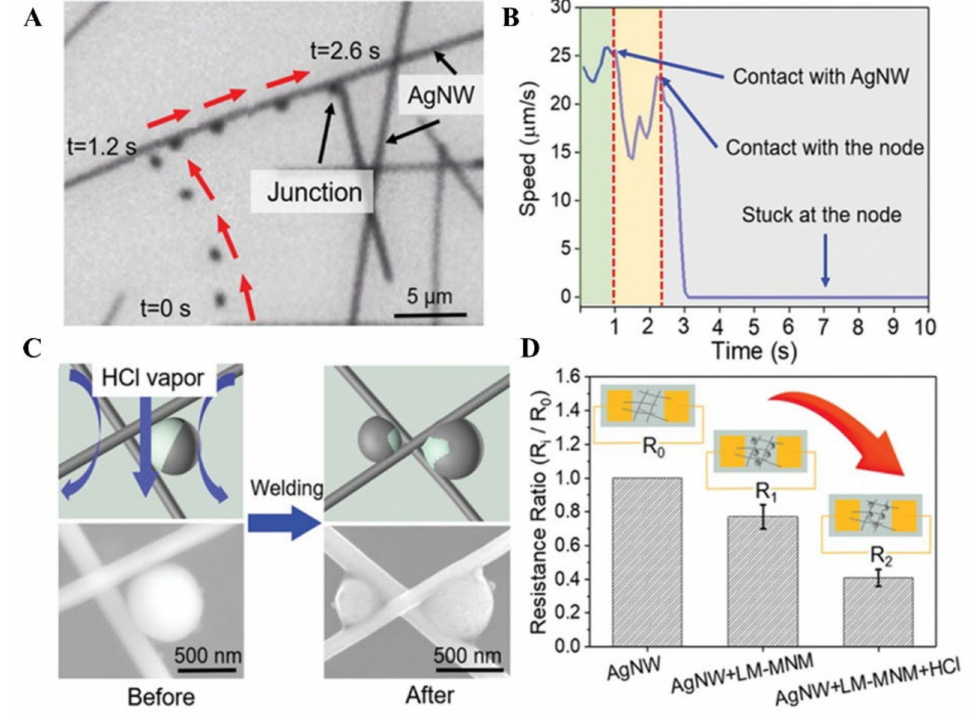
Figure 18. Micro welding application of MLMTs [6]. ( A ) Video snapshot and ( B ) instantaneous speed of MLMTs moving within the silver nanowire network (AgNW) network. ( C ) Schematic illustration and the corresponding SEM images of MLMTs stuck at an AgNW junction before and after HCl treatment. ( D ) The electrical resistance of a gapped gold electrode under different condi- tions: with AgNW network only (R 0 ), and with AgNW and MLMTs before (R 1 ) and after (R 2 ) HCl treatment,